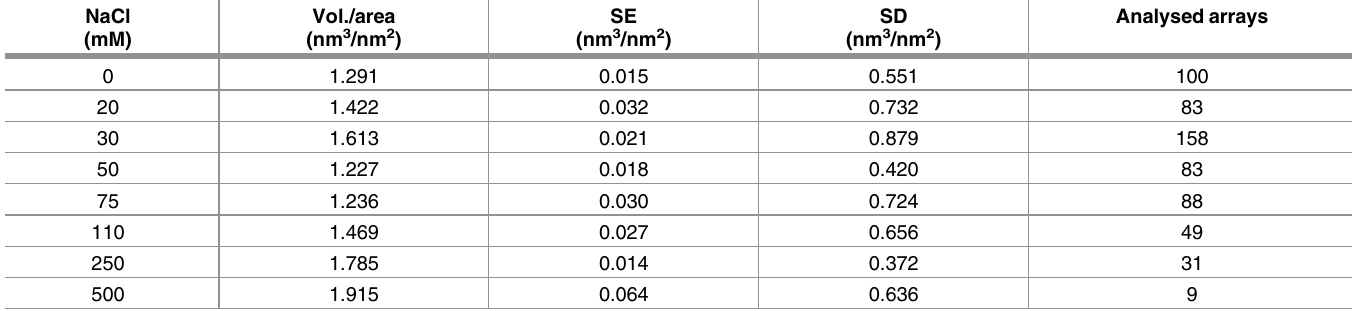
Table 1. Summaryof the analysed AFM data.